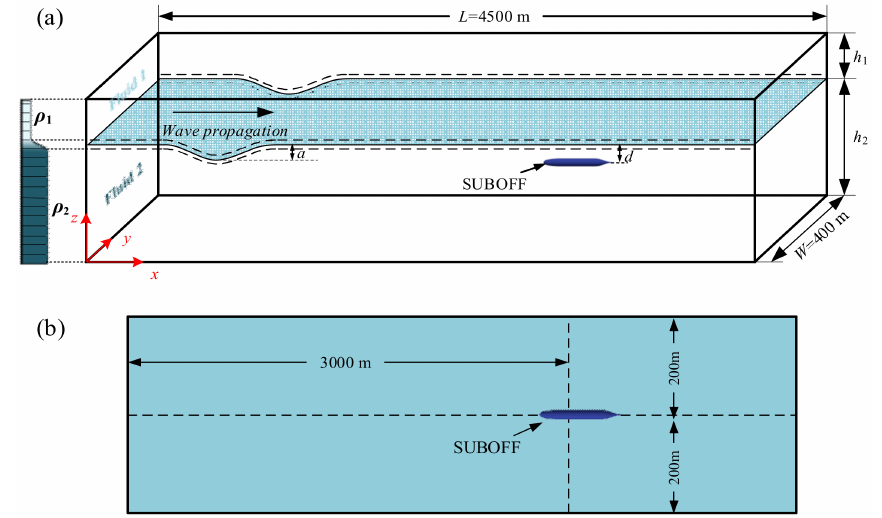
Figure 10. 3D numerical ISW wave tank: ( a ) sketch; ( b ) top view.